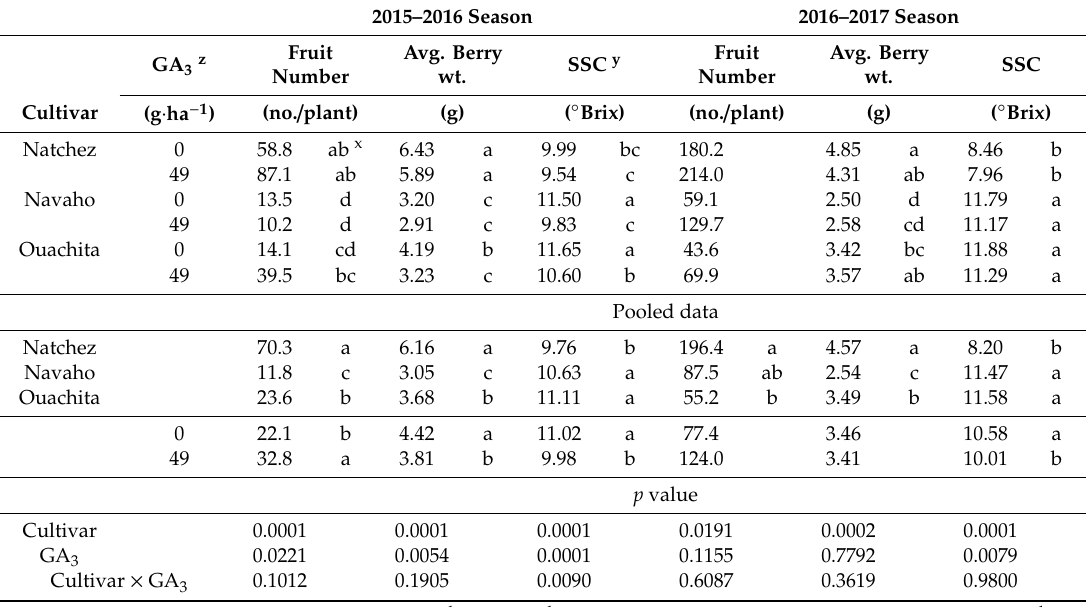
Table 4. E ff ects of gibberellic acid (GA 3 ) treatment on fruit number, average berry weight (wt.), soluble solids concentration (SSC) of ‘Natchez’, ‘Navaho’, and ‘Ouachita’ blackberry grown under subtropical